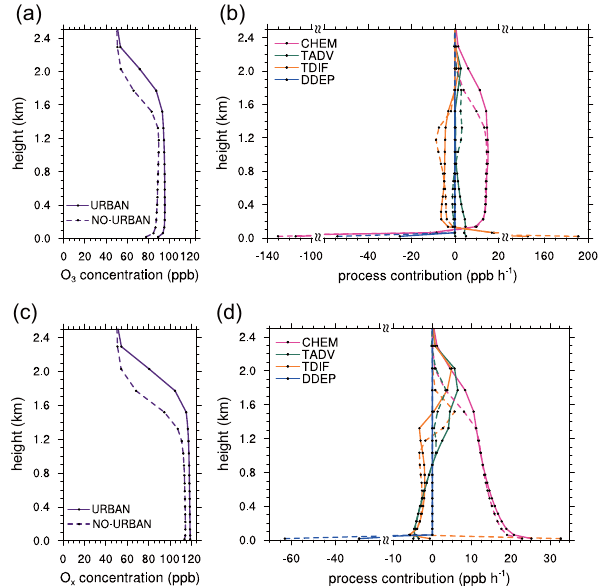
Fig. 7. 4-h-average vertical profiles of (a) O 3 and (c) O x concen- trations, and contributions of individual processes to (b) O 3 con- centration and (d) O x concentration averaged over the urban anal- ysis area for the period from 12:00 to 16:00 LT. Note that the solid (dashed) lines in (b) and (d) indicate the results of the UR- BAN (NO-URBAN) simulation. The same abbreviations for the processes as those in Fig. 6 are